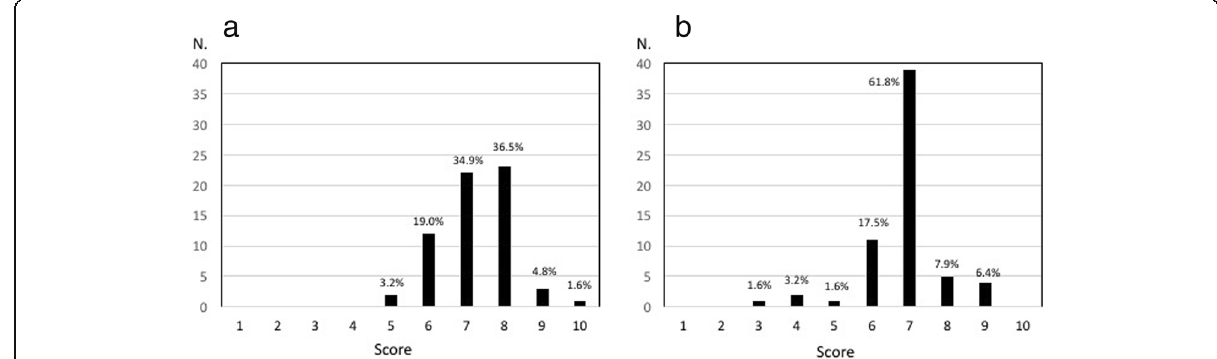
Fig. 4 Satisfaction with Onabotulinumtoxin A (OBT-A) treatment: a treatment satisfaction of clinicians; b treatment satisfaction of patients (as perceived by clinicians). Treatment satisfaction was rated on a scale from 0 (no satisfaction) to 10 (highest satisfaction)